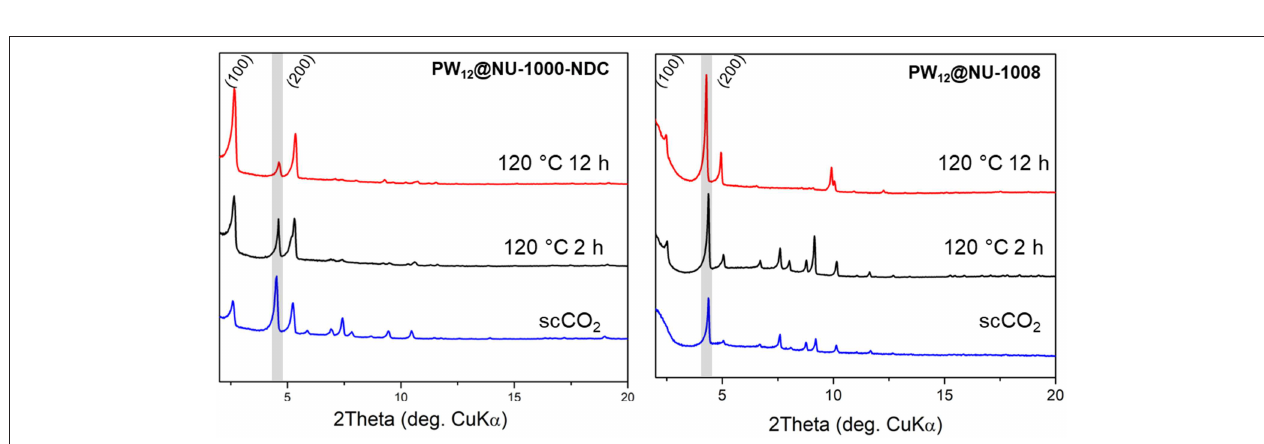
FIGURE 4 | Ex situ PXRD patterns of PW 12 @NU-1000-NDC (Left) and NU-1008 (Right) under specified activation conditions. Gray boxes the (2–10) reflection.